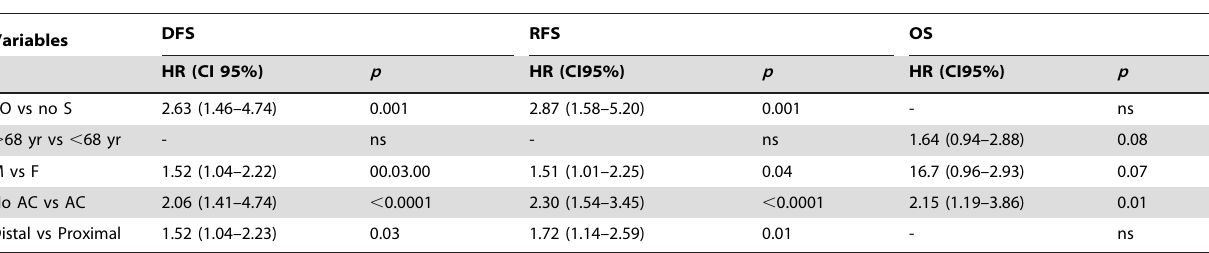
Table 3. Multivariate